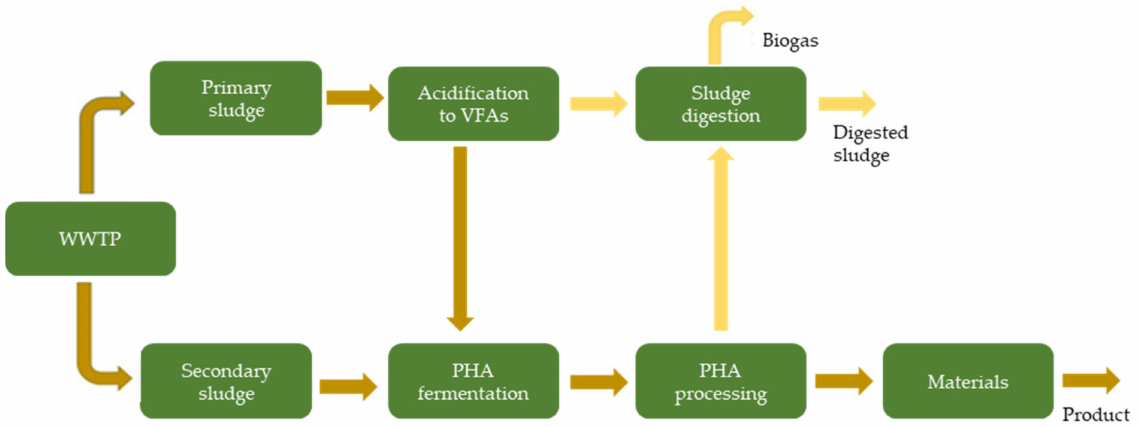
Figure 8. Production process of PHA via a wastewater treatment plant (WWTP) taken from